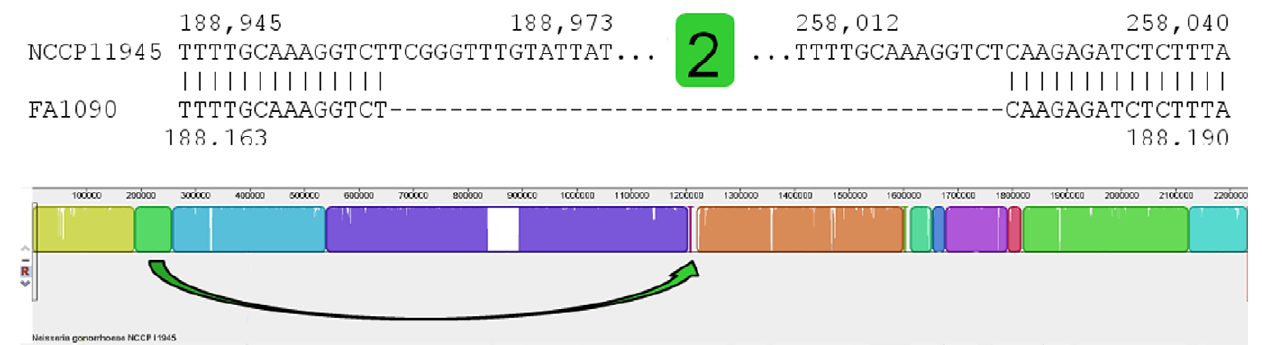
Figure 3. Model for the rearrangement of block 4. Block 4 (purple) is inverted in strain FA1090 relative to the orientation of this region of DNA in strains NCCP11945 (shown) and TCDC-NG08107. At the single base level the regions flanking block 4 from strains NCCP11945 (top) and FA1090 (bottom) align. It is within the flanking regions that homologous recombination is believed to have occurred, between copies of the , 650 bp Spencer-Smith Repeat Enclosed Elements that flank block 4 (Table 2, Table S7), resulting in the inversion observed (purple arrow; Figure